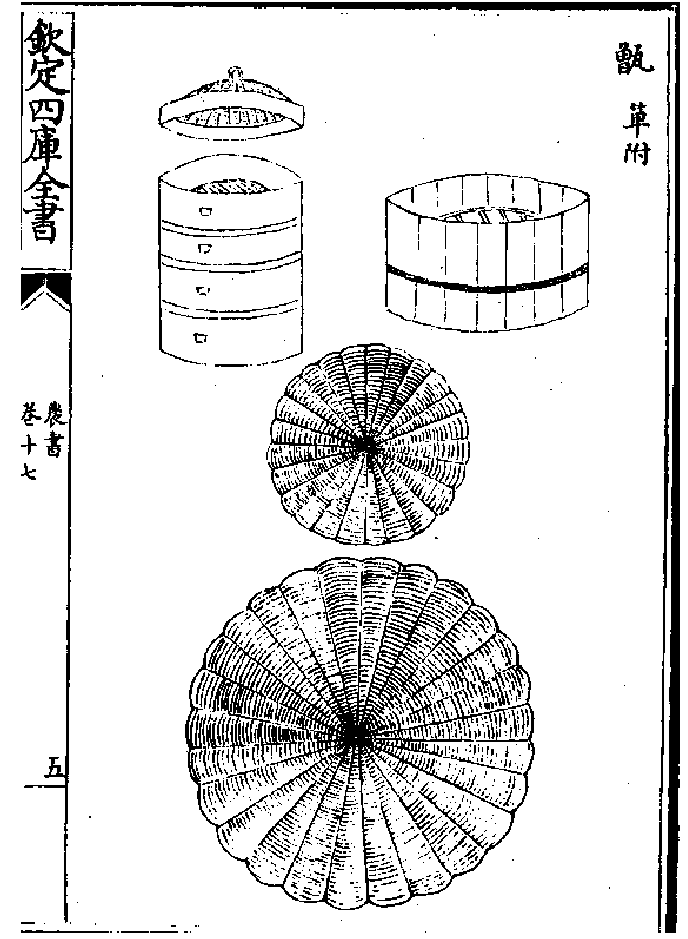
Figure 4. The structure of the steamer and bamboo mats for desalination in the ancient Chinese dynasties [56,57].